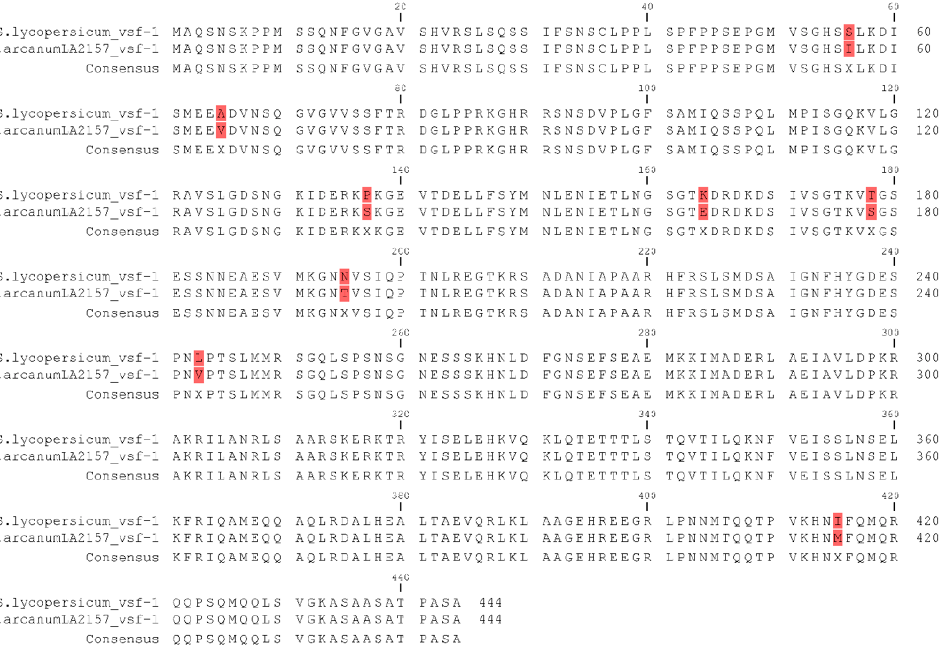
Figure 4. Alignment of the S. lycopersicum CYP90C1 protein against the predicted protein of the S. arcanum LA2157 allelic variant. Amino acids in red indicate changes between the two proteins. After alignment of the predicted S. arcanum LA2157 and the S. lycopersicum vsf-1 ( Solyc04g081190.3) proteins, we detected 8 amino acid changes between the protein se- quences (Figure 5).